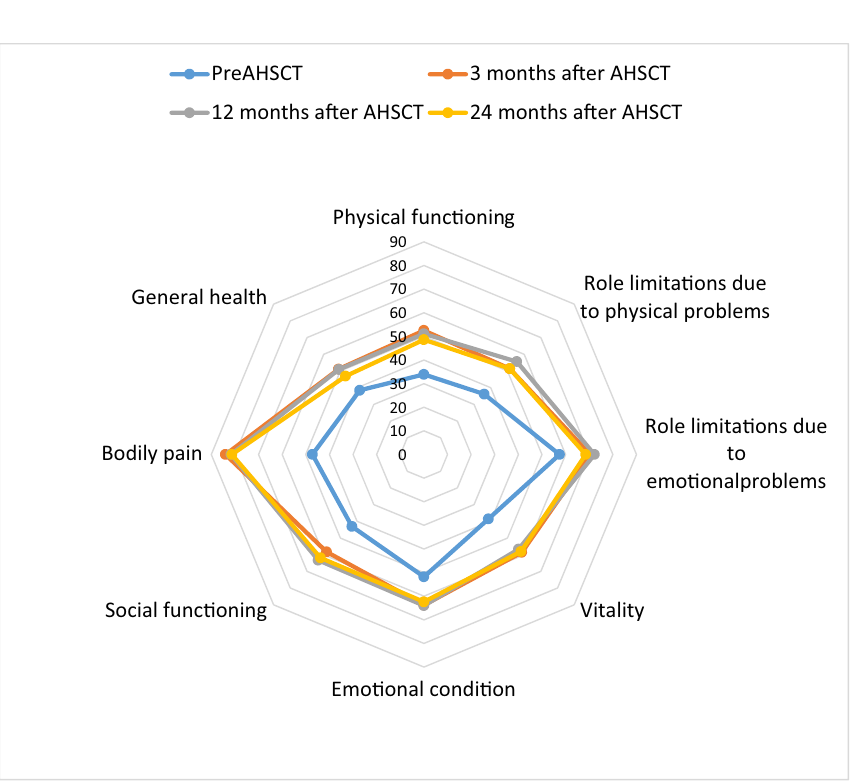
Figure 2. HRQoL in patients with MS before and at Month 3, Month 12 and Month 24 after AHSCT. Scored on a 0–100 scale (0 = low HRQoL; 100 = high QoL). AHSCT autologous haematopoietic stem cell